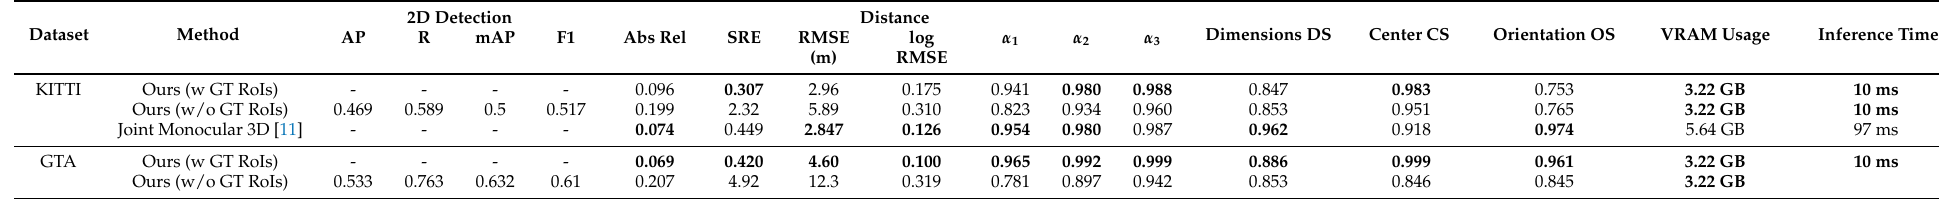
Table 1. Quantitative results of our method for both KITTI and GTAV datasets. The evaluation was performed on the validation split of the datasets. Since accuracy metrics for the 2D detection (RoI) were not available for [11], only ours are displayed. The bold numbers represent the best score for each metrics for each dataset.